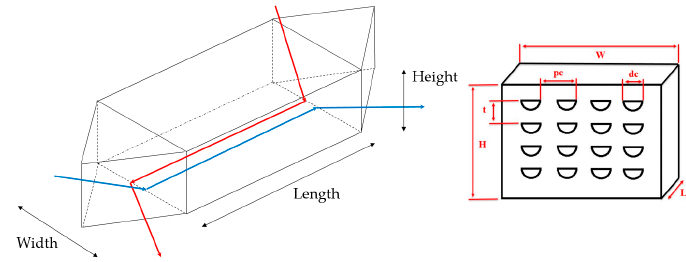
Figure 5. Simplified schematic of the recuperator’s geometric parameters.